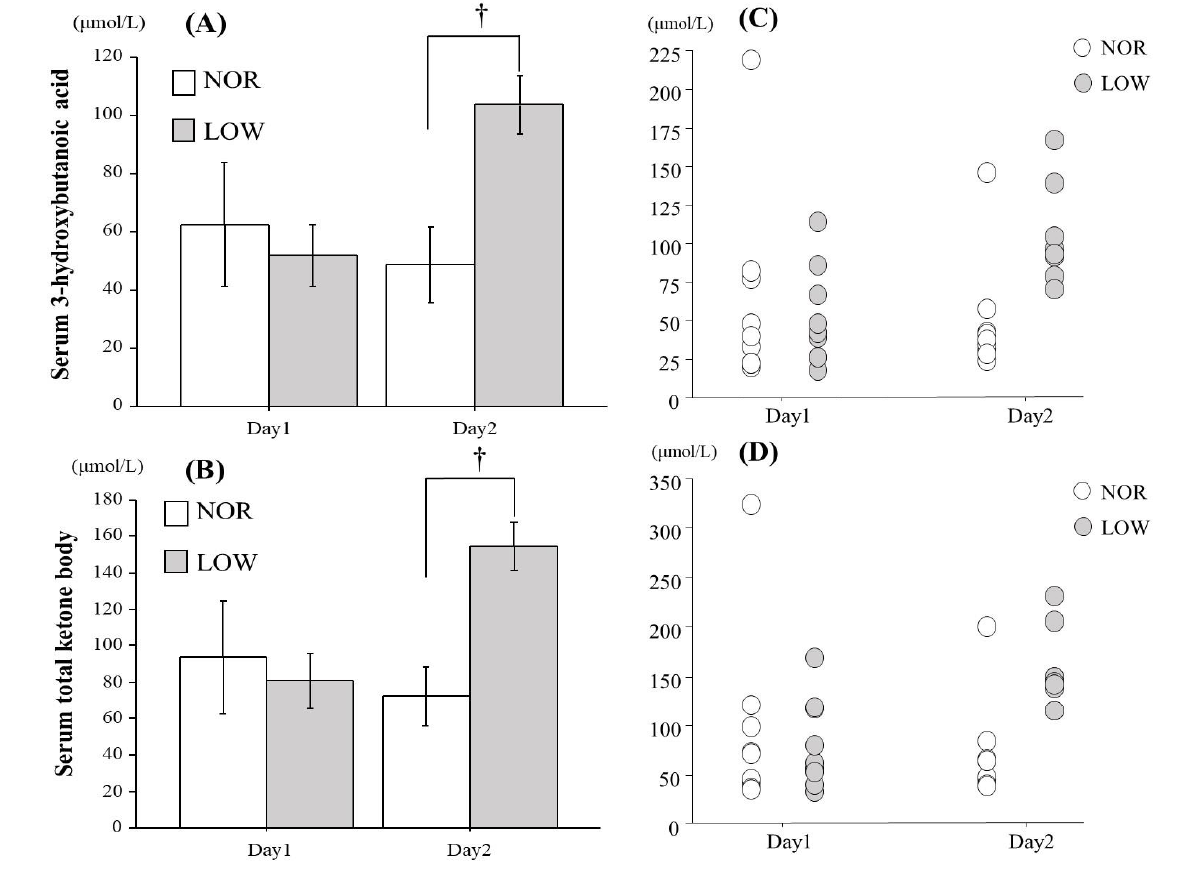
Figure 3. Changes in mean value of serum 3-hydroxybutanoic acid ( A ), total ketone body concentration ( B ), individual Figure3. Changesinmeanvalueofserum3-hydroxybutanoicacid( A ),totalketonebodycon- value of serum 3-hydroxybutanoi cacid ( C ) and total ketone body concentration ( D ). Values are means ± SE. † p < 0.05 vs. centration( B ),individualvalueofserum3-hydroxybutanoicacid(C)andtotalketonebodycon- centration(D).Valuesaremeans±SE.†p<0.05vs.trial